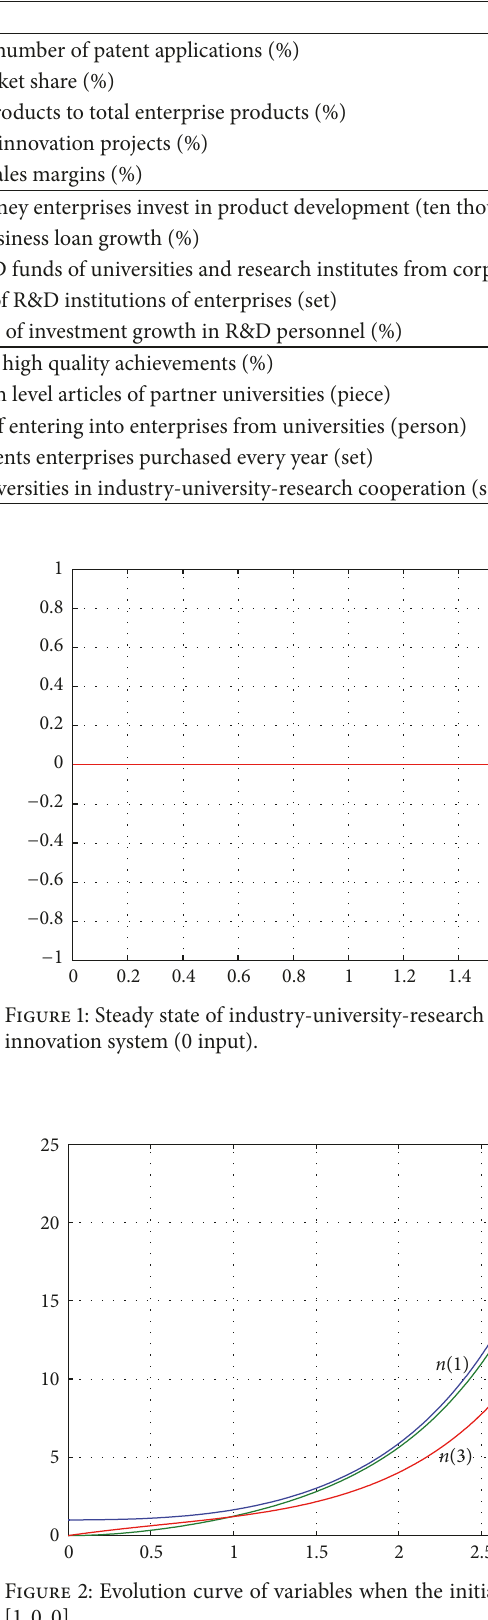
Table 1: Index system of Chinese industry-university-research collaborative innovation system evolution.